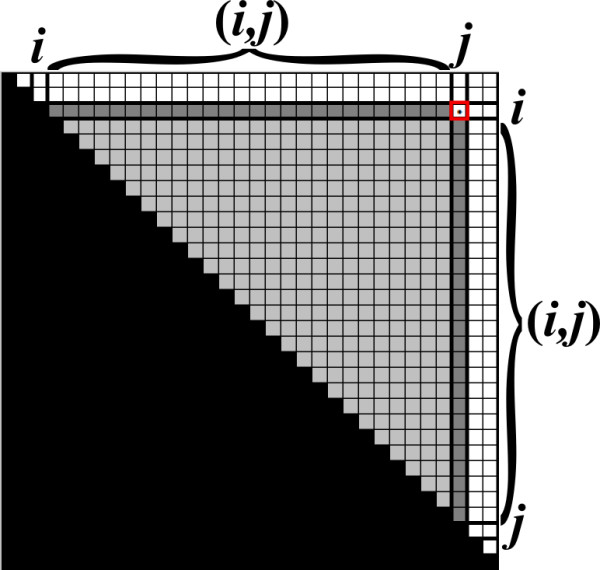
The table B maintained by the DP algorithm. In order to compute Bi, j, the algorithm needs to examine only values in entries of B that correspond to strict substrings of si, j (depicted as light and dark grayed entries).